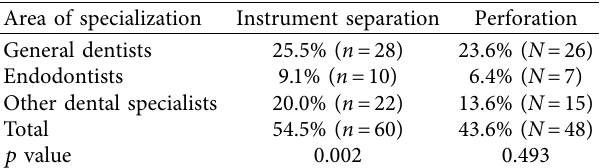
Table 3: Percentage of respondents who had experienced in- strument separation and/or perforation during previous root canal